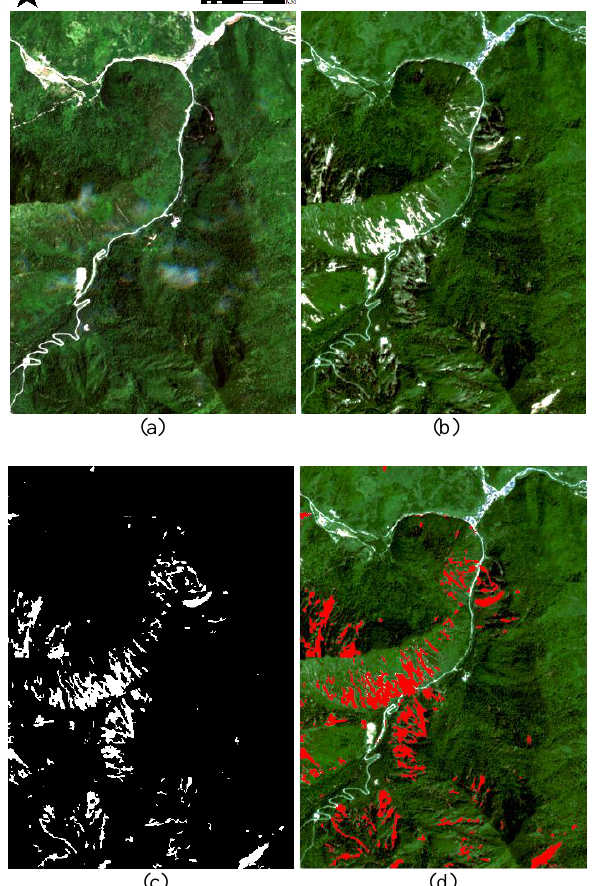
Figure 1. Test data. (a) Pre-event Sentinel-2 image. (b) Post- event Sentinel-2 image. (c) Manually digitized reference landslide inventory map. (d) Landslides in (c) overlaid on the post-event